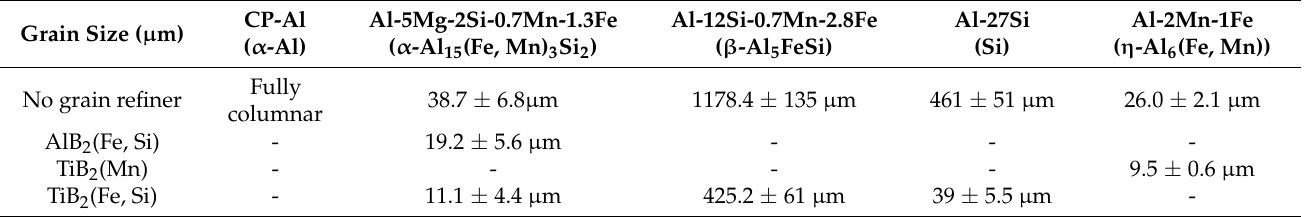
Figure 19. Interfacial segregation of Mn at the α -Al/ 1010 TiB 2 interface. ( a ) Scanning transmission electron microscopy (STEM) Z-contrast high-angle annular dark field (HAADF) image of Al/TiB 2 interface in Al-3.7Ti-1.5B alloy, viewed along 1 1 2 0 TiB 2 direction; and ( b – d ) Super-X EDS elemental mapping of ( b ) Al, ( c ) Ti, and ( d ) Mn [82]. Table 5. Refinement of different phases in Al